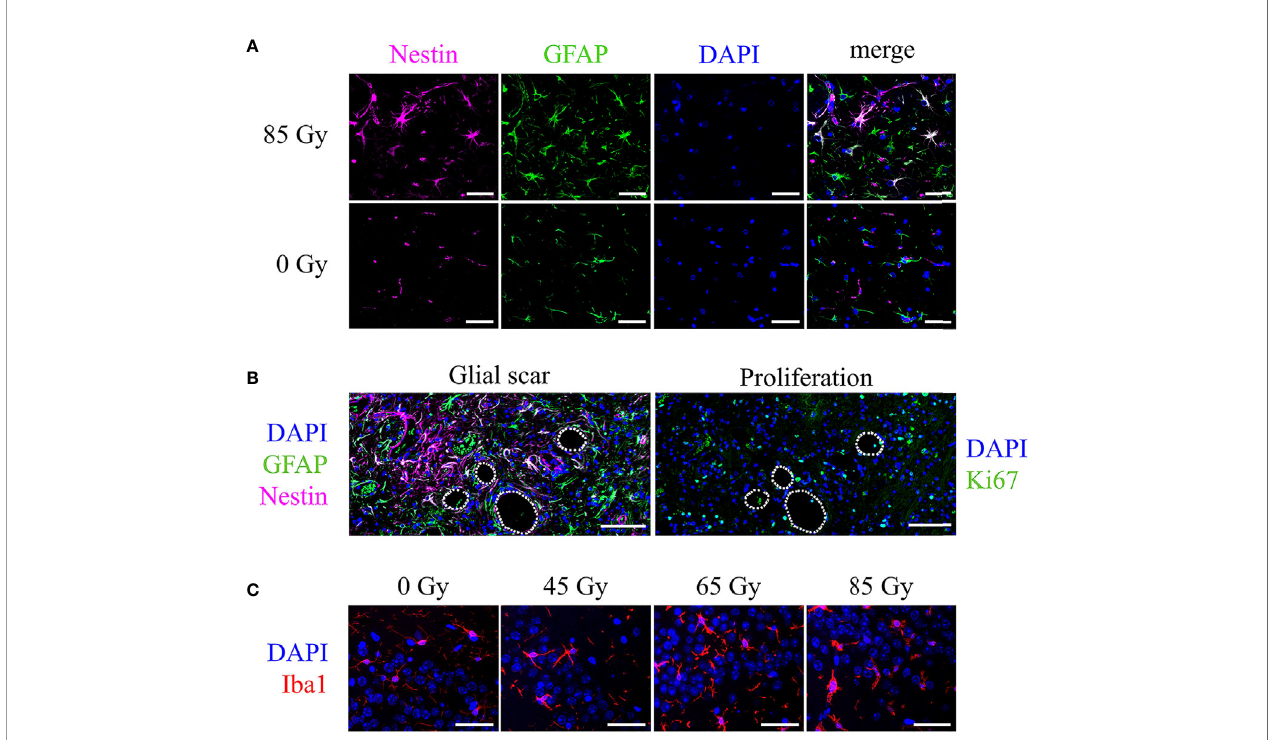
FIGURE 11 | Cell type speci fi c markers and cell nuclei (DAPI, blue) in representative irradiated brain sections of C57BL/6 mice. (A) Nestin-positive vessels (pink), GFAP-positive astrocytes (green), and Nestin-GFAP double-positive astrocytes in an animal irradiated with 85 Gy. No double-positive cells appear in the control animal. Scale bar 50 µm. (B) Consecutive slices showed the glial scar (left, Nestin-GFAP double-positive cells, green and pink) and proliferating, Ki-67-positive cells (right, green) located in the irradiated brain area, mainly around edema (white lines, 65 Gy). Scale bar 100 µm. (C) Iba1-positive microglia (red) increased in number and changed their morphology upon proton irradiation. Higher doses exhibit a bushy or amoeboid-like shape. Scale bar 50